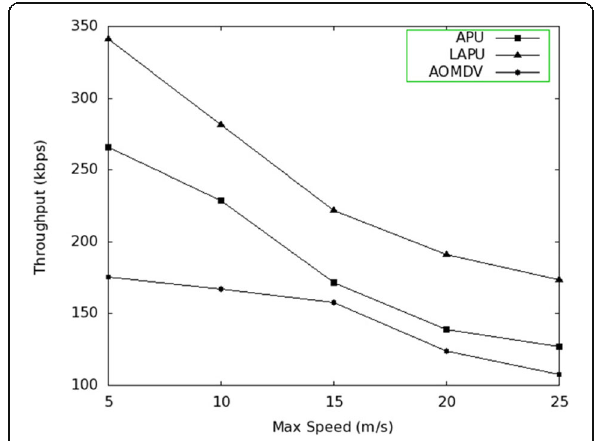
Fig. 8 Average energy consumption vs. node